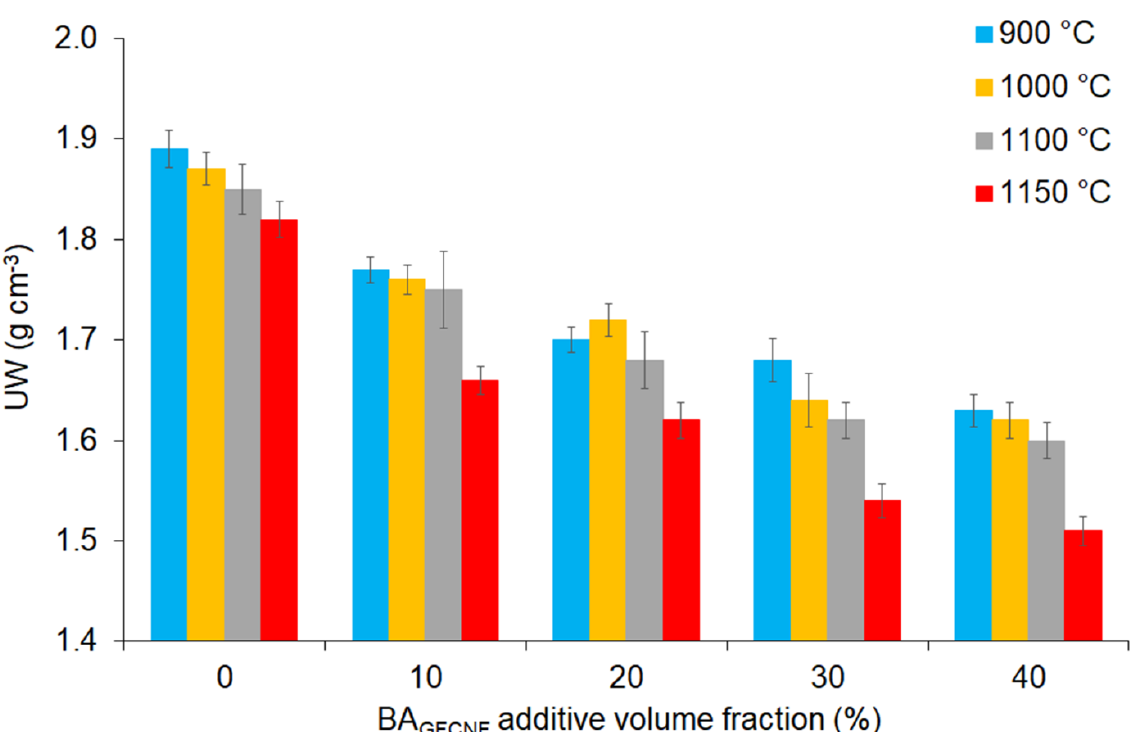
Figure 4. The values of UW depending on the BA GFCNF content, which ranged from 0 to 40%, and firing temperatures applied in the range of 900 to 1150 °C .